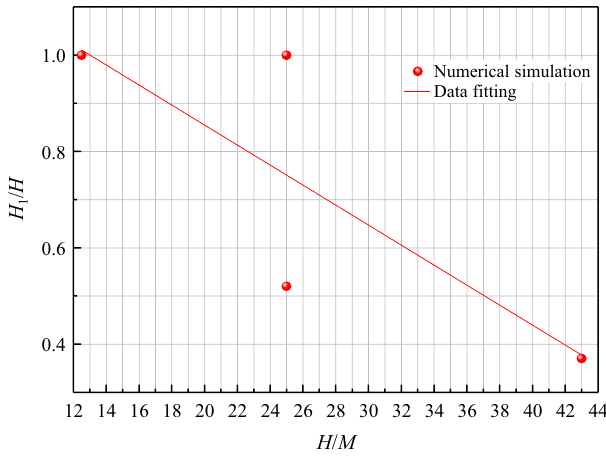
Figure 13. Relationship between H / M and H 1 / H .